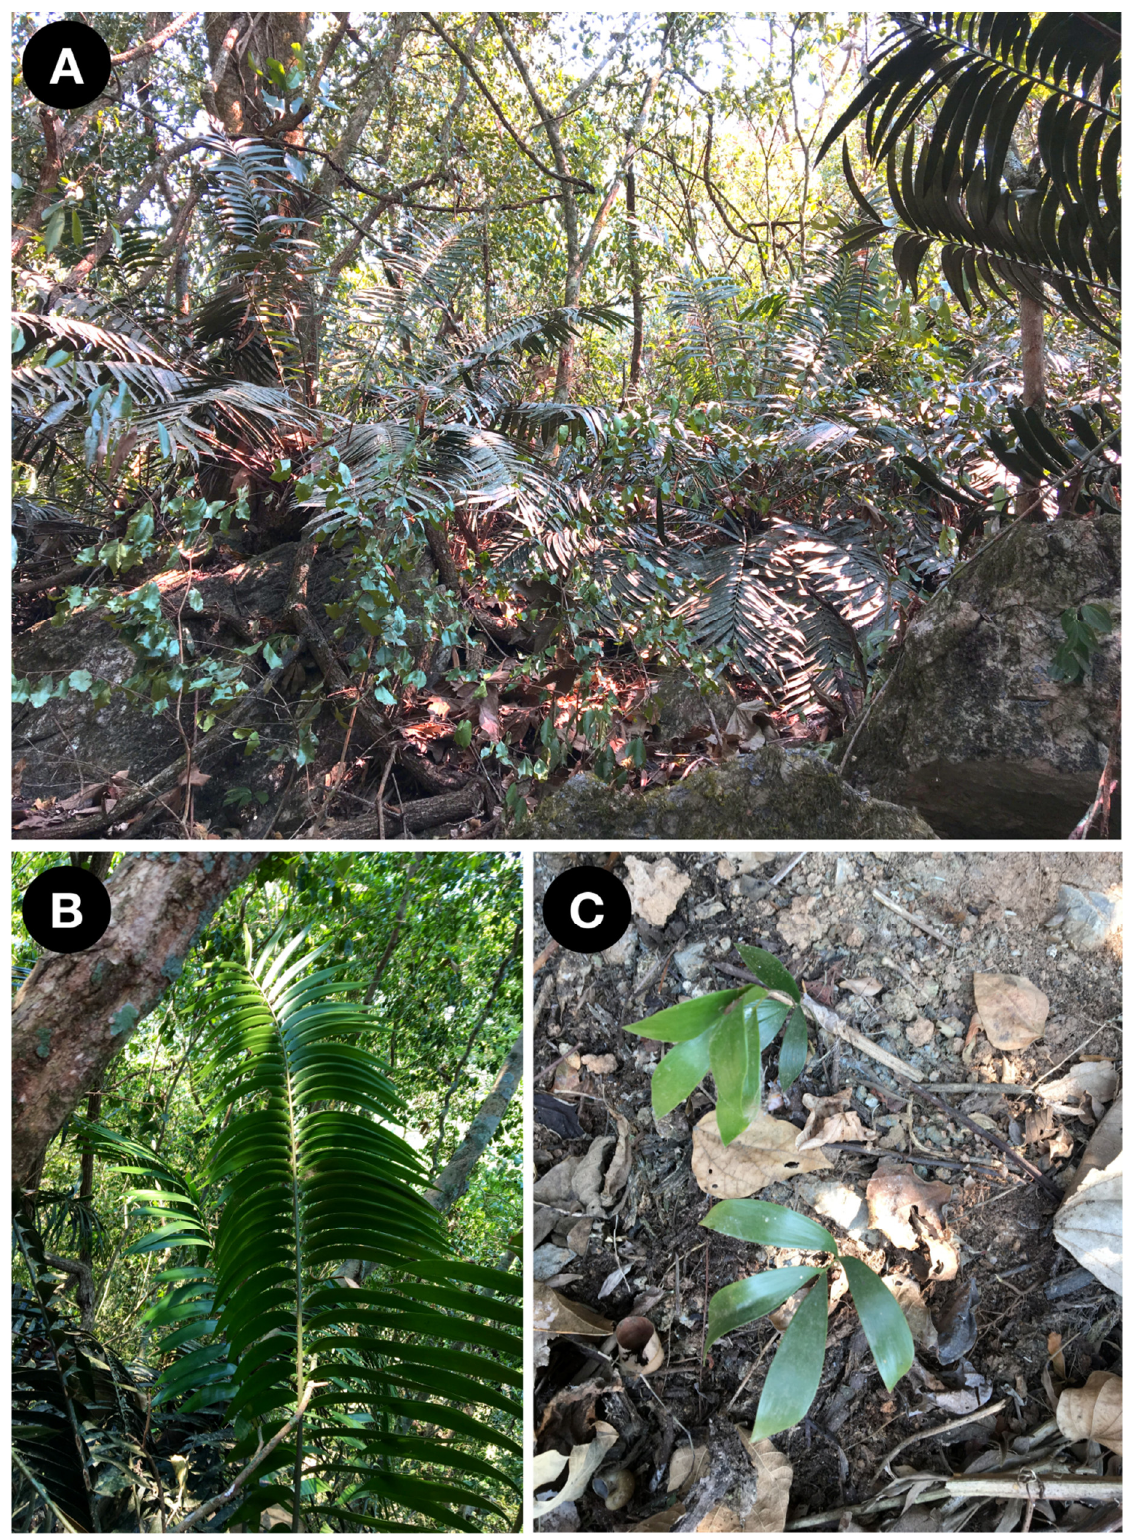
Figure 4. Ceratozamia schiblii sp. nov. in habitat. ( A ) Adult plants. ( B ) Erect leaves and details of leaflets. ( C ) Seedlings.